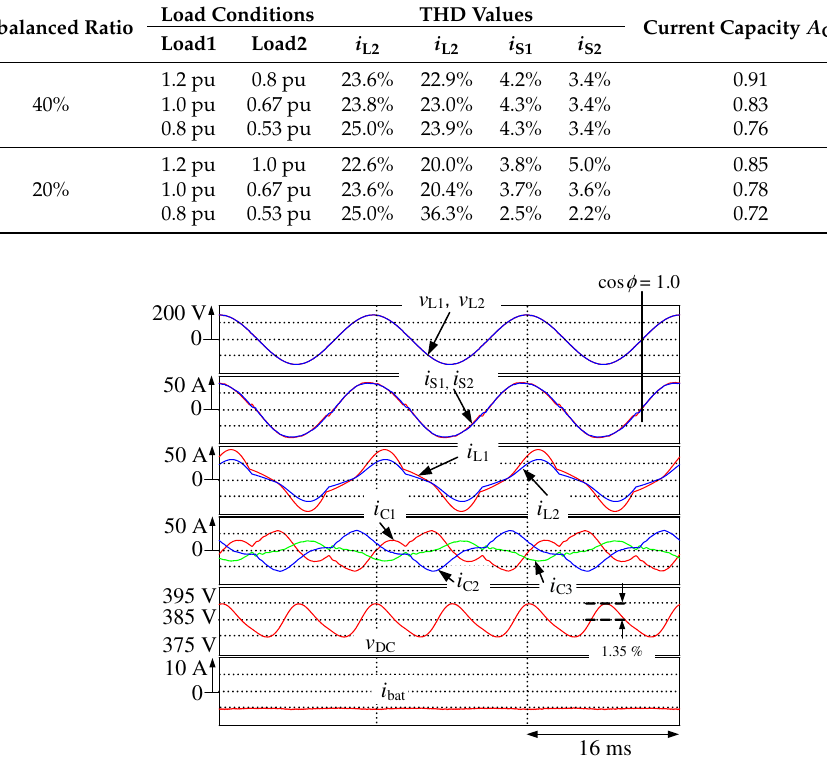
Figure 7. Simulation results for Figure 4 during battery-charging